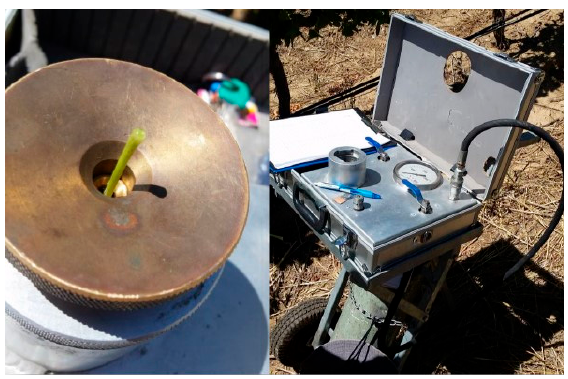
Figure 2. Customised pressure chamber used to measure Stem Water Potential.